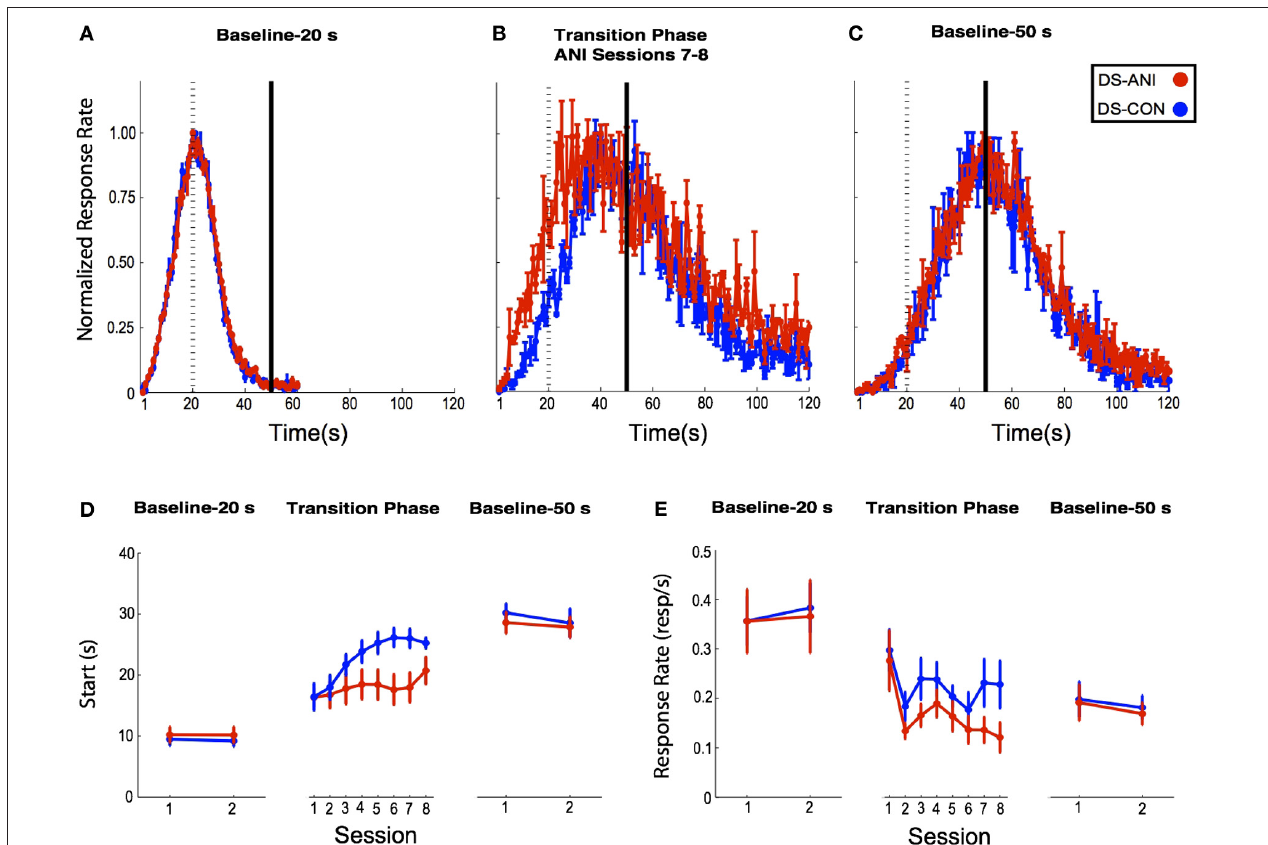
treatment groups. The Baseline 20s PI and Baseline 50s PI “Start” times during each session correspond to the peak functions displayed in Figures 2A,C . During the transition phase, individual data were smoothed across 10 sessions of microinjections using a running median with a 3-session window. (E) Mean ( ± SEM) response rate (responses/s) on probe trials during the three specified phases of the experiment for the DS-CON and DS-ANI groups. ANI = anisomycin; CON = control; DS = dorsal